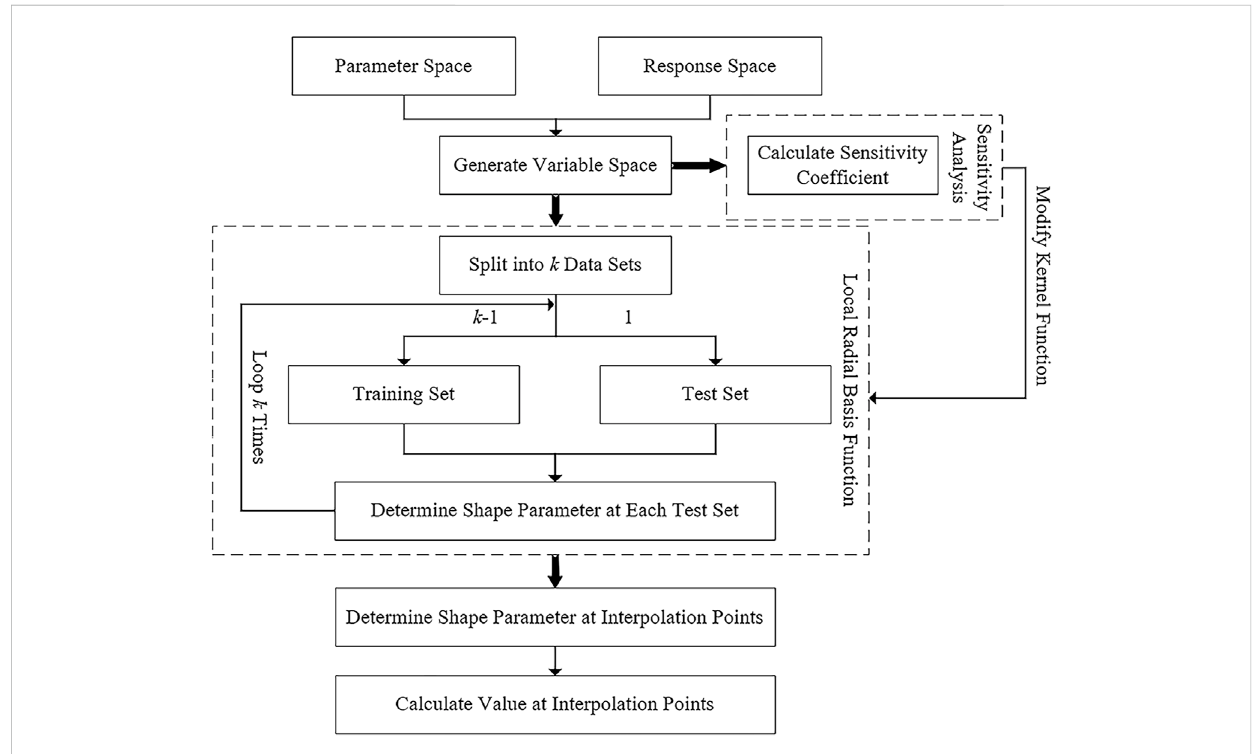
FIGURE 1 Flow chart of interpolation algorithm based on local radial basis